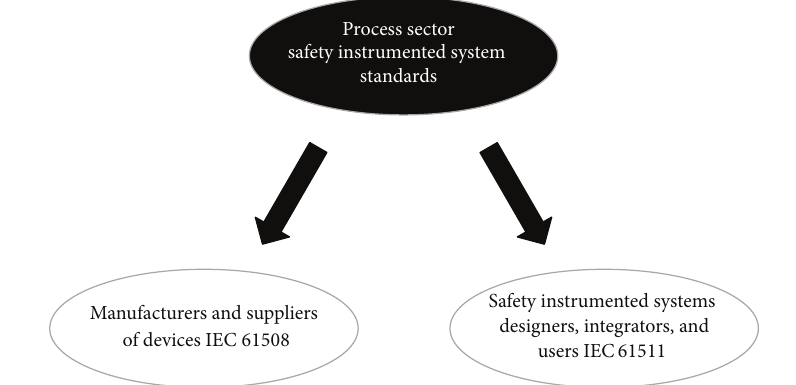
Figure 1: Relationship between IEC 61508 and IEC 61511.